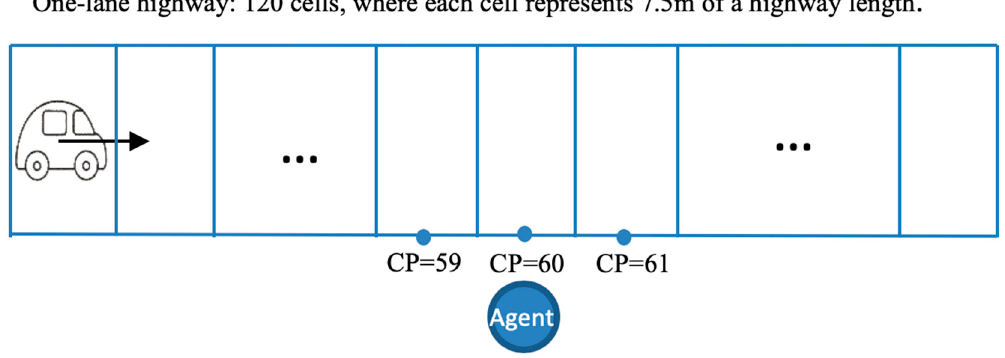
Figure 1. The diagram describes three main components of the simulation model: highway, vehicles, and agents. In our simulation, agents are generated at the crossing point (CP) = 60 and they can move randomly to the neighboring crossing points. Each simulation run features 1511 time steps.